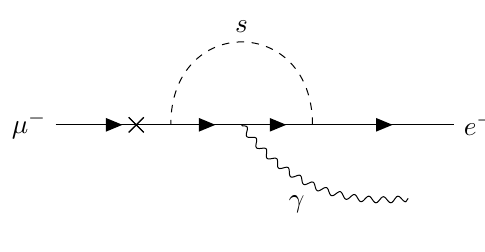
Figure 2 . Representative Feynman diagram for (cid:22) ! e(cid:13)